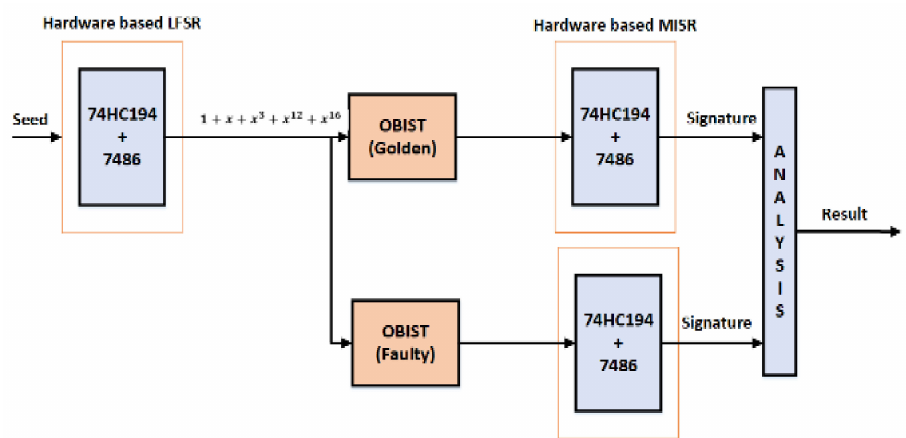
Figure 3. Online built-in self-test (OBIST) block diagram composed of a hardware-based linear feedback shift register (LFSR), golden and faulty signature databases, as well as a hardware-based multiple input signature register (MISR); (adapted from